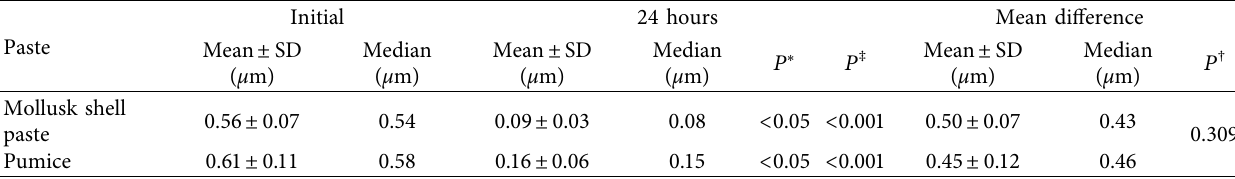
Table 1: In vitro evaluation of the surface roughness of the experimental mollusk shell paste versus pumice. Paste